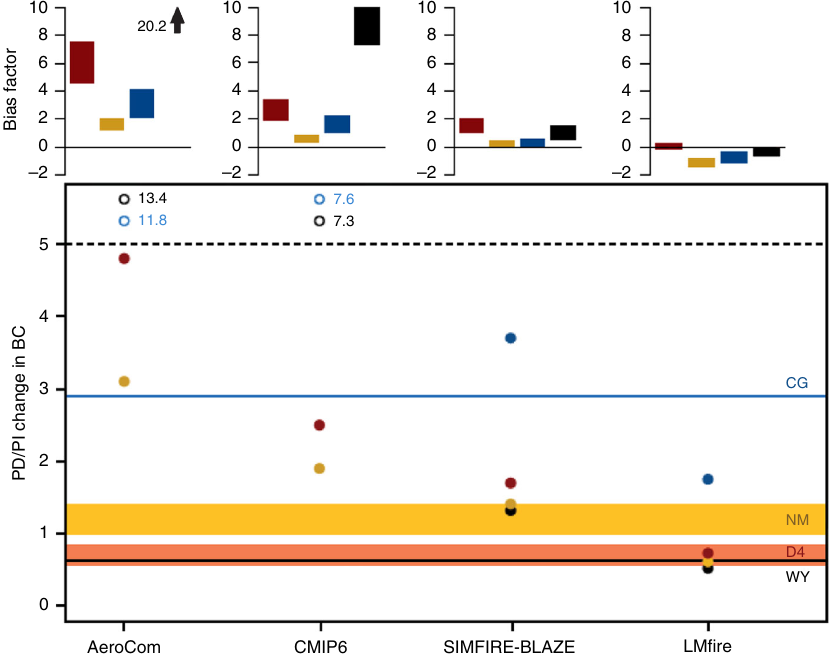
Fig. 2 Present-day/pre-industrial ratio in ice core and modelled black carbon concentrations. Shown are two Greenland sites (D4 and NM), one North American site at Wyoming (WY), and one Swiss Alps site at Colle Gnifetti (CG). Bias factor in the present-day/pre-industrial (PD/PI) ratio for each modelled fi re emission scenario (D4: red bars, NM: gold bars, WY: black bars, CG: blue bars). For model M and observation O the symmetric bias factor was calculated as: For M > O: (M/O) – 1; For O > M: – (O/M) + 1. The AeroCom bias factor at the WY site is off the scale and shown as an arrow with its bias factor given. Measured PD/PI values shown as horizontal bars (±standard error of the mean bound Greenland estimates, see Methods) with the model simulations PD/PI ratio shown as dots (D4: red, NM: gold, WY: black, CG: blue). The WY and CG modelled ratio changes are scaled by a factor of 1.6 (1.2 – 2.0 in bias factor panel) and 2.0 (1.5 – 2.5 in bias factor panel) respectively to account for the change in BC concentration emissions near the site between the period of the PD measurement and the modelled concentration (see Methods). The AeroCom and CMIP6 changes at the WY and CG sites are off the scale and shown as open circles with the PD/PI ratio